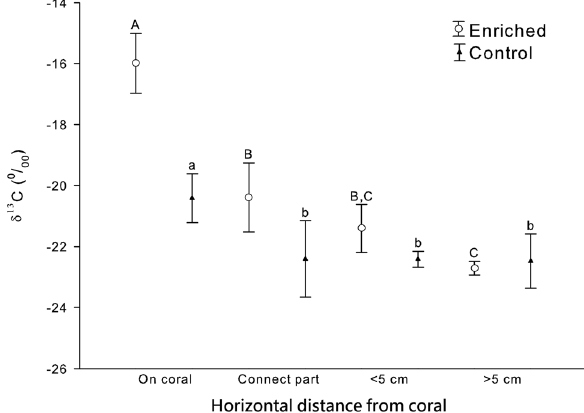
Figure 5. Stable carbon isotope composition (δ 13 C) of Terpios hoshinota grown on and at different positions in control and enriched ( 13 C) corals. Error bars indicate 95% c.i. Different letters indicate significant difference (Upper letter: Enrich group; Lower letter: Control